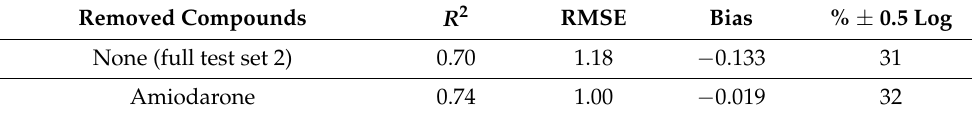
Table 6. Statistical MPPs obtained on test set 2 after removal of outliers. Removed Compounds R 2